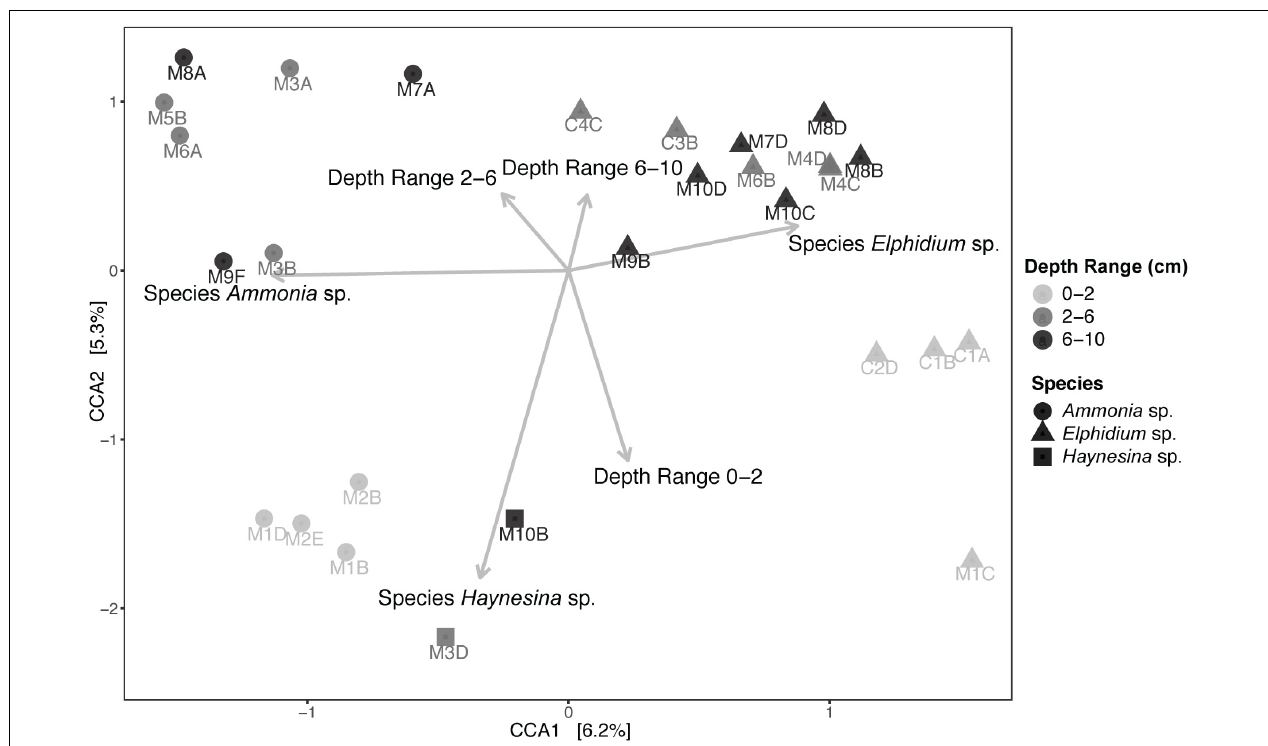
FIGURE 5 | Canonical Correspondence Analysis (CCA) of foraminiferal intracellular eukaryote content (excluding foraminiferal OTUs) and potential explanatory variables. Specimens from different sediment depths (cm) are grouped in three depth ranges: 0–2, 2–6, and 6–10 cm. “M” indicates foraminiferal specimens from Mokbaai and “C” from de Cocksdorp. Arrows, indicating the correlation between the canonical axes and the explanatory variables, are only shown for the significant variables. Average organic carbon content (in weight % of dry sediment), average total nitrogen content (in weight % of dry sediment) and average C/N per depth range (C mol/ N mol) were also included in the CCA model but were not significant ( p > 0.1). Organic carbon and nitrogen content values are shown in Supplementary Table 2 .